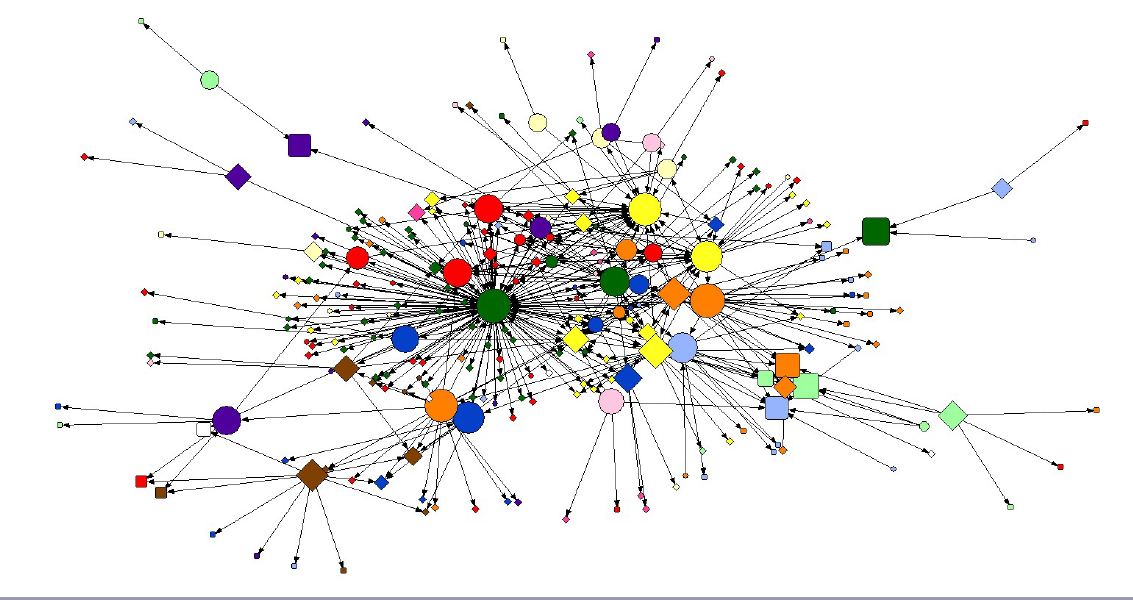
Fig. 3 . Communication network of the natural park and assistance to the advisory committee meetings. Note: The size of the nodes indicates the betweenness and the shapes indicate the assistance to the advisory committee meetings (circle for assistance, diamond for no assistance, rounded-square for missing data, i.e., institutions). In addition, the following colors are used to denote the various categories: red (local administration); green (park managers); yellow (park employees); blue (agricultural sector); orange (scientific sector); purple (civic sector); pale green (conservationist sector); pale blue (leisure sector); pale yellow (environmental education/tourist sector); brown (forestry sector); pink (accommodation and restaurants); pale pink (other enterprises); and white